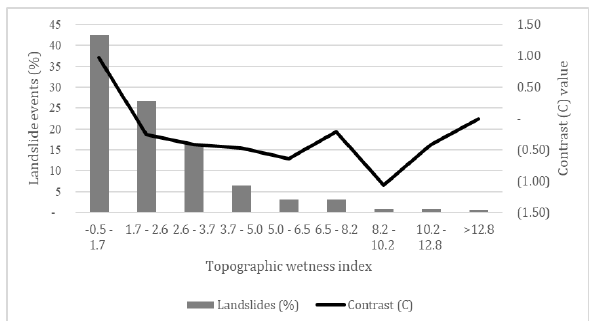
Figure 6 Landslide distribution (%) left vertical axis) and contrast value (right vertical axis) in relation to topographic